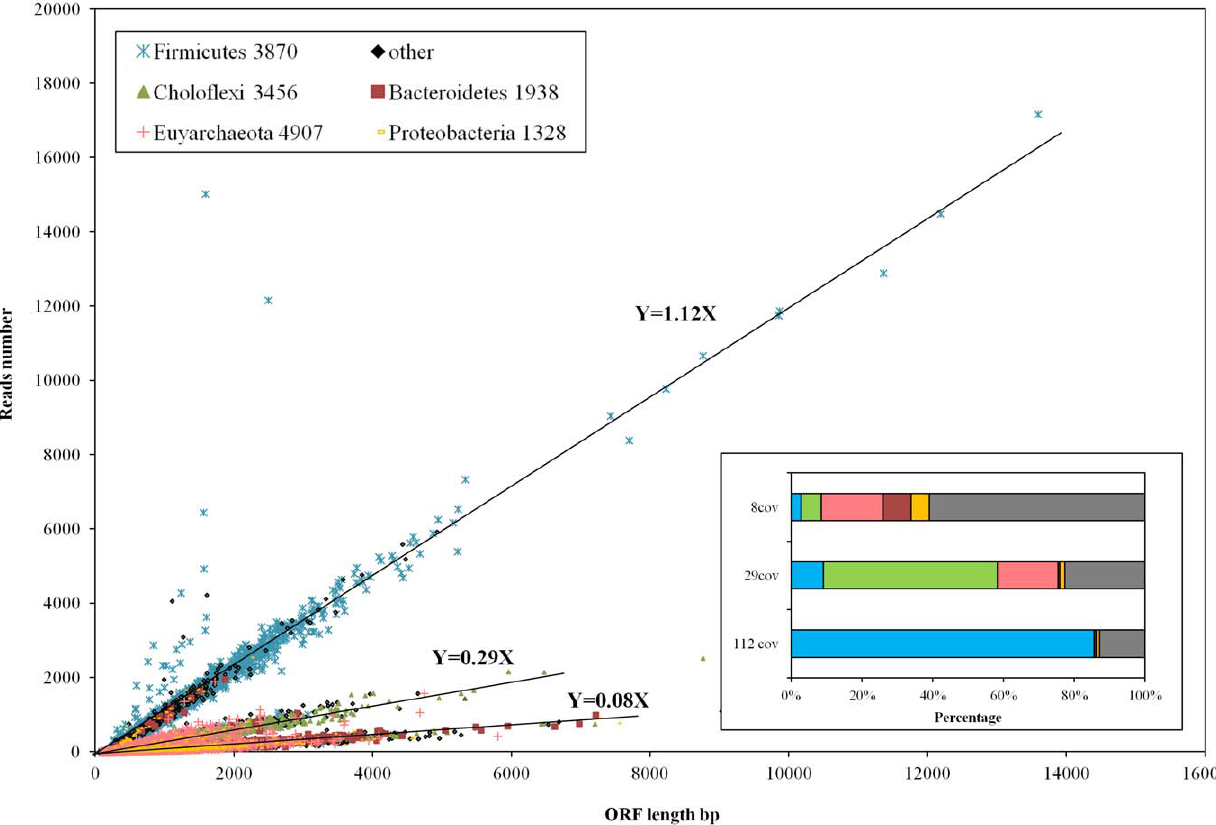
Figure 1. Plot of the number of reads aligned to each ORF as a function of the length of the ORF. The ORFs were generated from contigs longer than 1000 bp. The number of reads aligned to each ORF was determined by SAMTools package. The ORFs were colored according to their taxonomy classification by MEGAN’s LCA algorithm at phylum level. The number of ORFs assigned to each phylum was listed following the phylum name. Insert: taxonomy distribution of ORFs in the three coverage trends demonstrated in the outside frame.